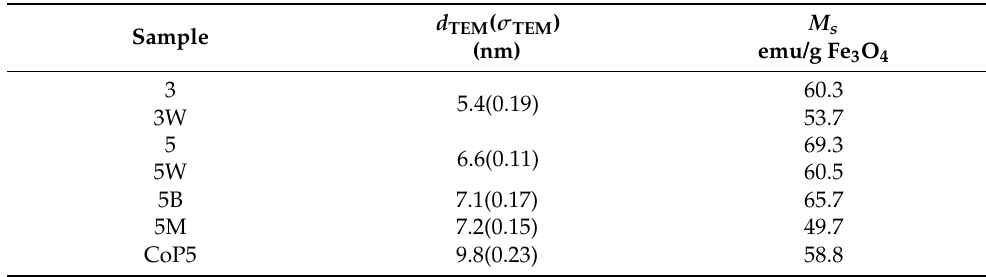
Table 3. Mean diameter d TEM obtained from TEM images and its standard deviation σ TEM , and saturation magnetization M S obtained from the magnetization curves at room